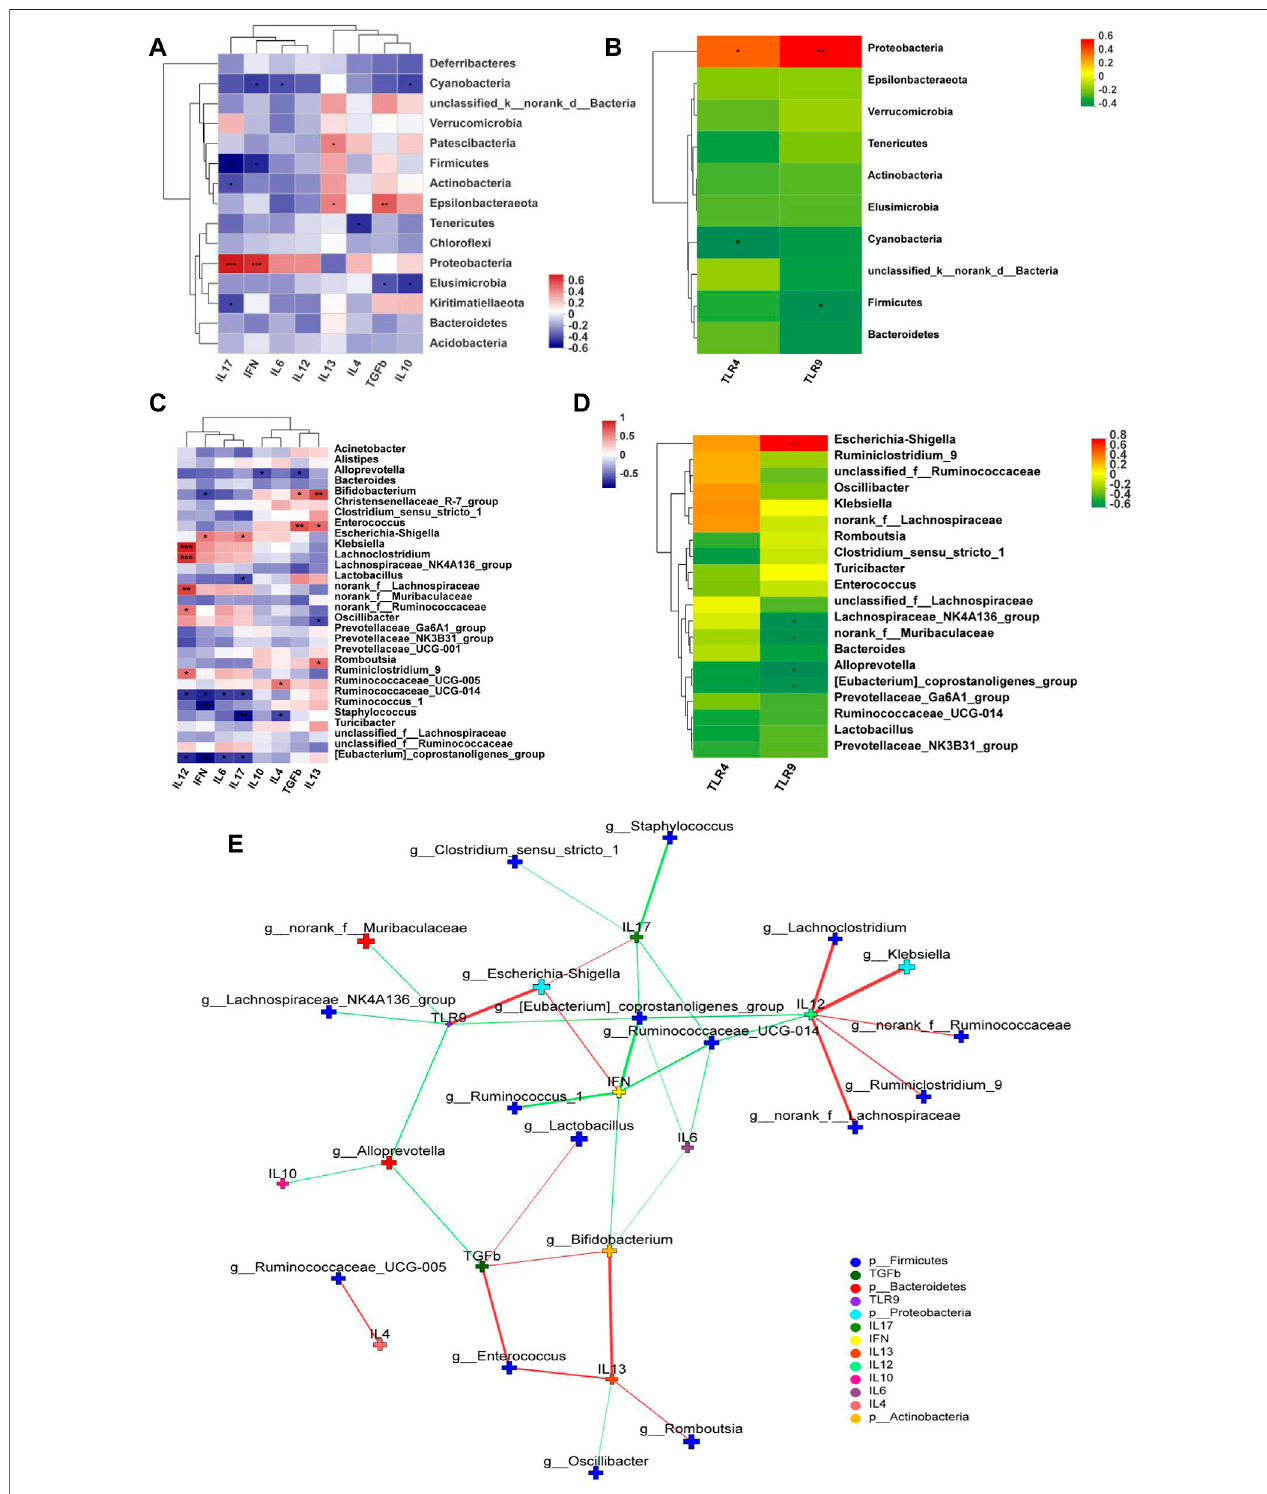
FIGURE 8 | Correlation Heatmaps and network analysis ( n = 6). Correlation heatmaps of (A) cytokines and gut microbiota at the phylum level; (B) TLRs and gut microbiotaatthephylumlevel; (C) cytokinesandgutmicrobiotaatthegenuslevel; (D) TLRsandgutmicrobiotaatthegenuslevel; (E) networkanalysis.The fi gureshows p < 0.05, correlation > 0.3, the top 30 species abundance. The size of the nodes indicates the abundance of the species, and different colors indicate different species. The color of the line indicates positive (red) and negative (green) correlation.